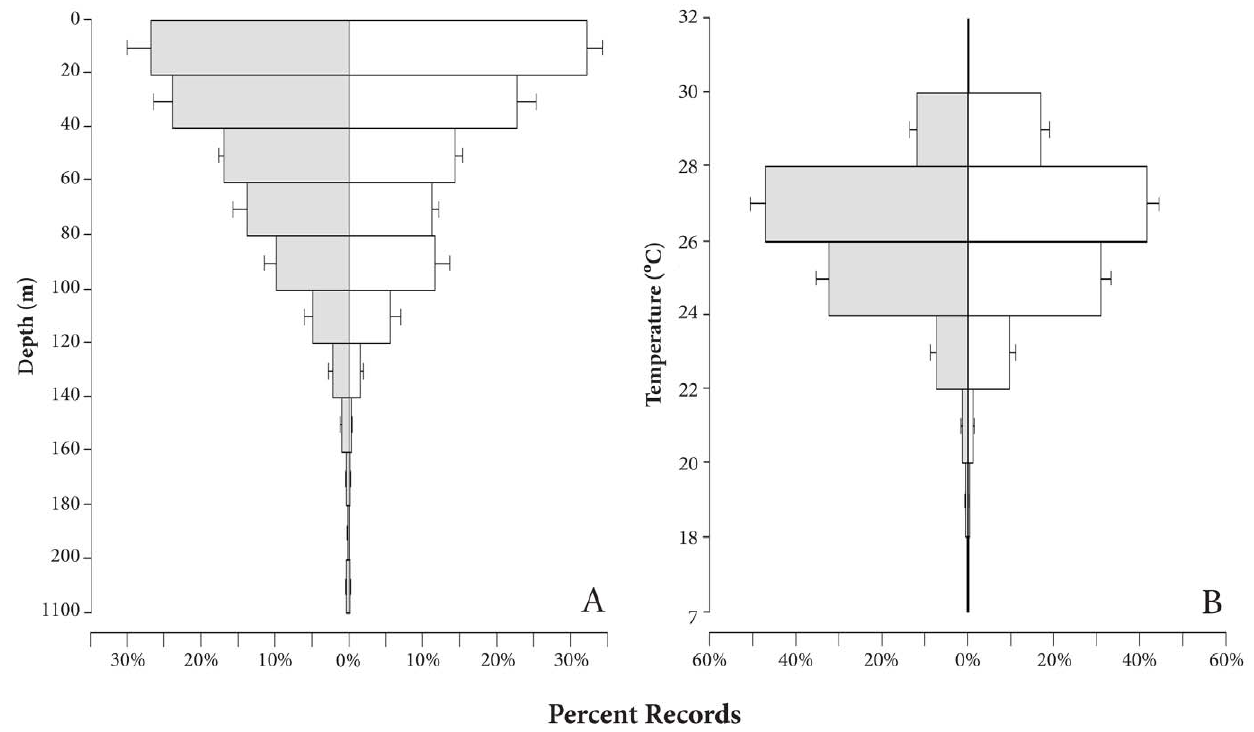
Figure 6. Percent records for night (gray) and day (white) for 11 tracked individuals. Mean ( 6 SE) percent records for A) depth (m) and B) temperature ( u C) for all tagged sharks.